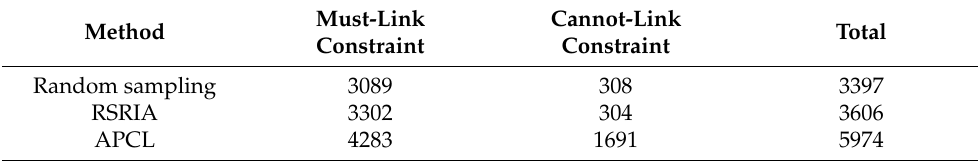
Table 5. Number of unsatisfied constraints in the unconstrained clustering results.